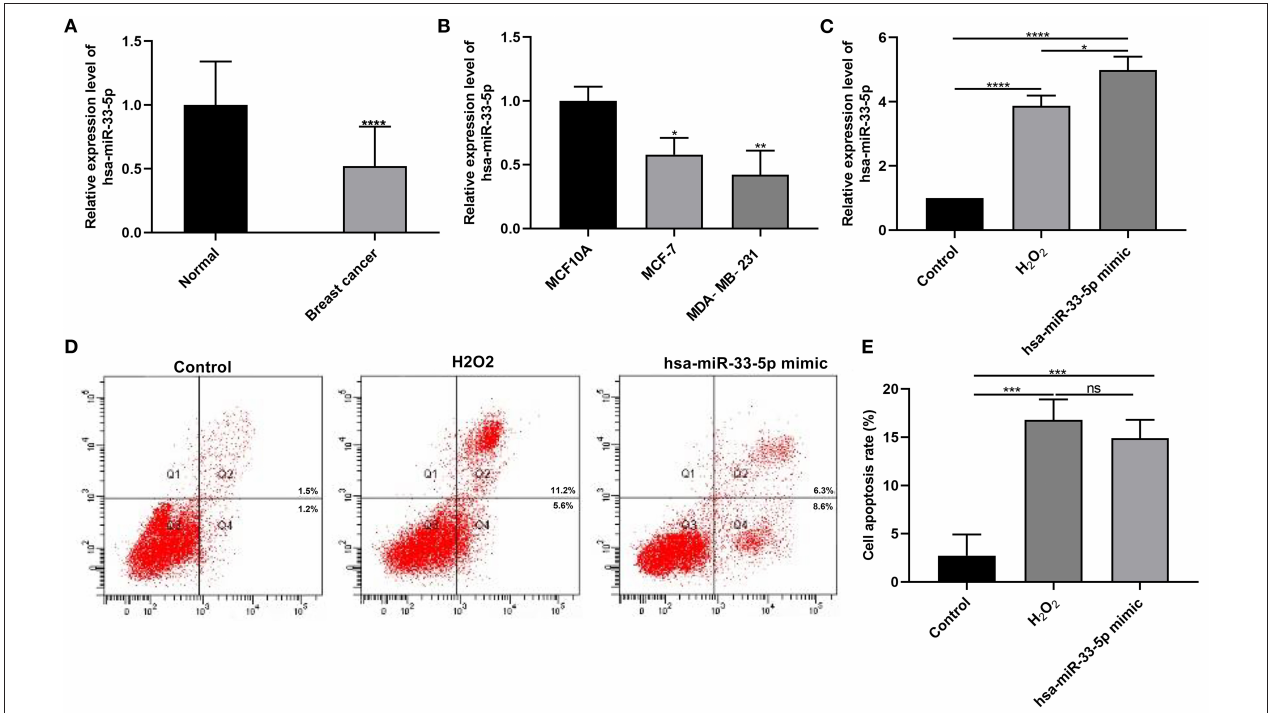
FIGURE 1 | hsa-miR-33-5p is downregulated in breast cancer, and its overexpression promotes the apoptosis of breast cancer cells. (A,B) RT-qPCR results showing downregulated hsa-miR-33-5p both in breast cancer tissues (A) and cells (B) . (C) RT-qPCR showing hsa-miR-33-5p expression in MCF-7 cells following transfection by hsa-miR-33-5p mimics. (D,E) Flow cytometry for the cell apoptosis in MCF-7 cells under transfection by hsa-miR-33-5p mimics. * p < 0.05; ** p < 0.01; *** p < 0.001; **** p < 0.0001; ns, not